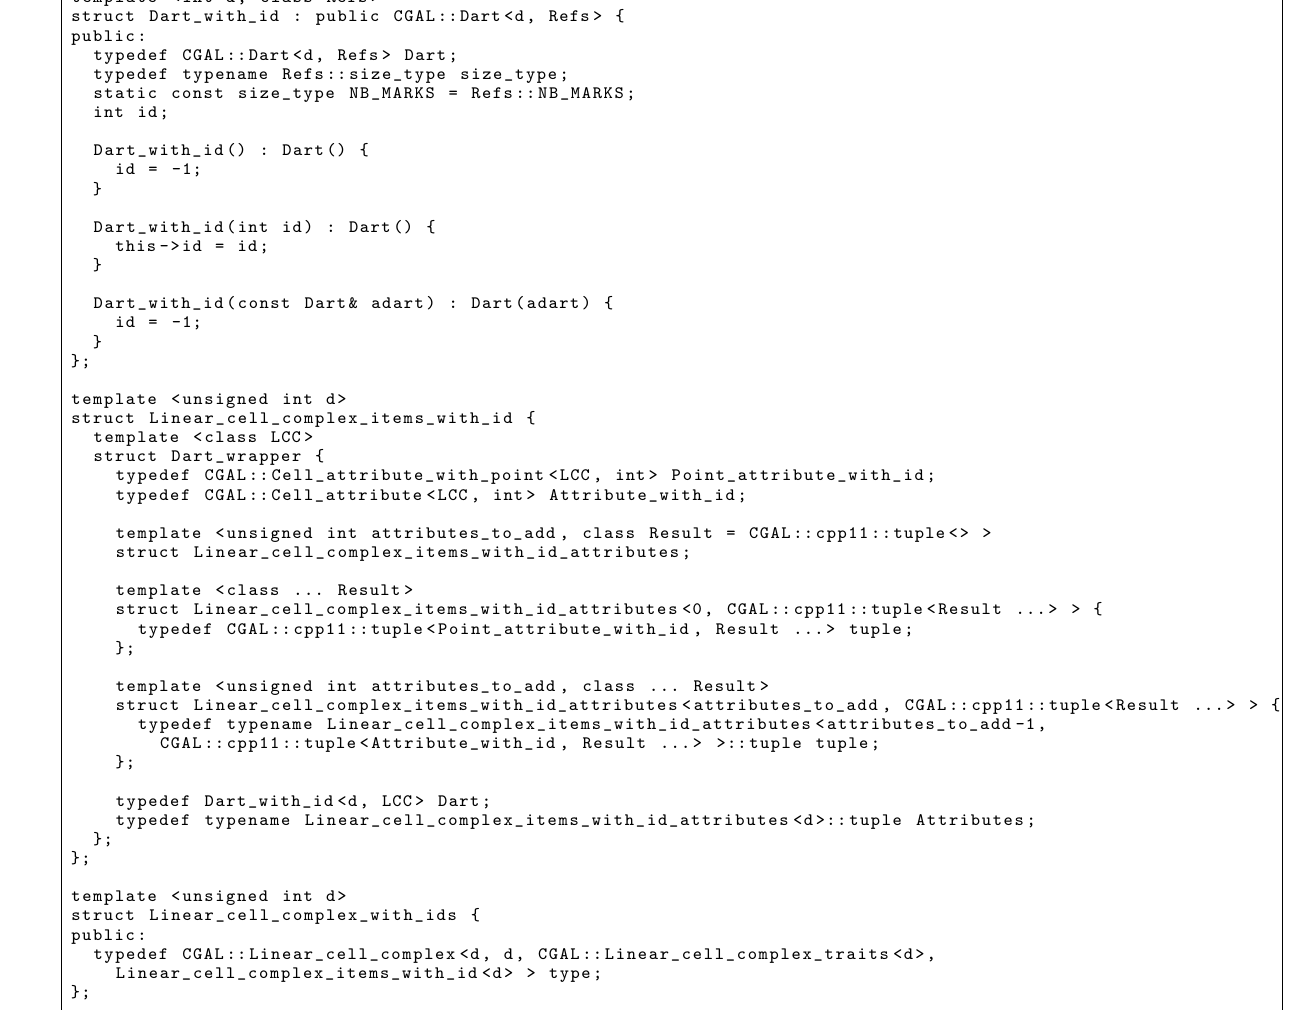
Figure 9: Custom Dart with id and Linear cell complex with id classes. Dart with id stores an integer id per dart, while Lin- ear cell complex with id stores an integer ID for every cell of every dimension. The latter is templated with the dimension d of the cell complex, whereafter it is used to add integer attributes for every cell of dimension higher than zero. This example uses variadic templates to show how it is possible to do this in a fully dimension-independent